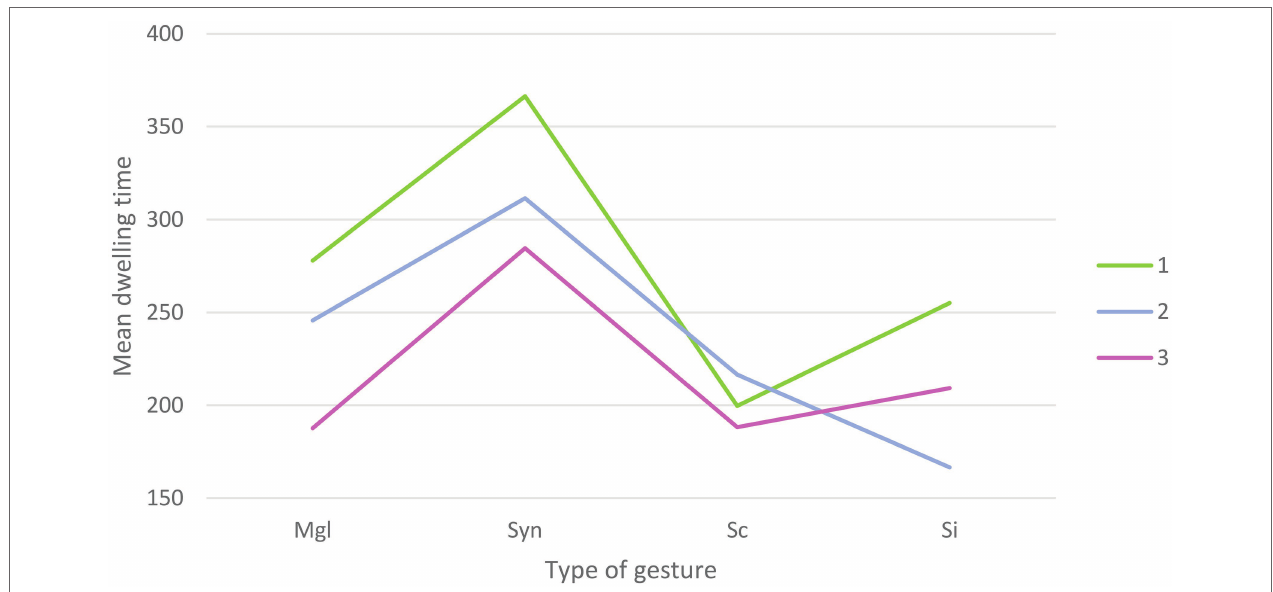
FIGURE 2 | Graphical representation of the interaction for dwelling time between the types of gestures presented and the level of hearing alteration (Mgl = Meaningless; Syn = syntactically incongruent; Sc = semantically congruent; SI = semantically incongruent).